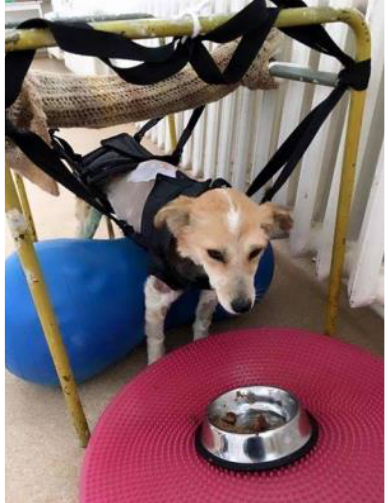
Figure 1. Paraplegic dog supported in the standing position by